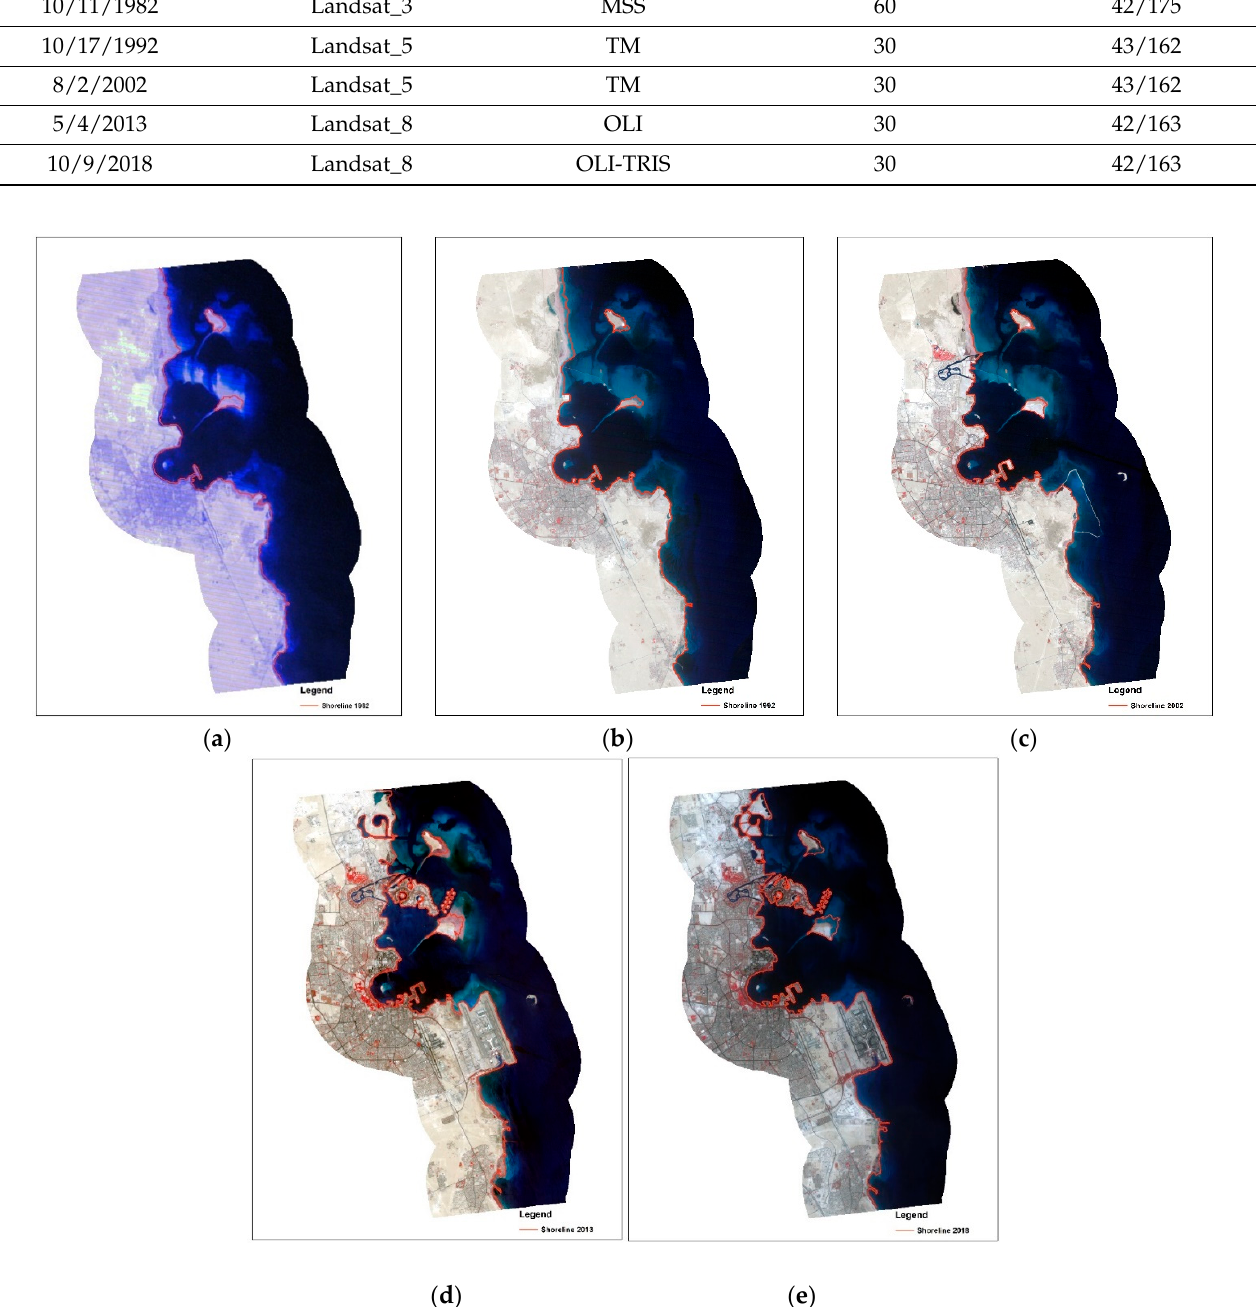
Figure 4. False colour composite image of ( a ) 1982, ( b ) 1992, ( c ) 2002, ( d ) 2013, and ( e ) 2018. Table 2. List of satellite images used in this study, showing their